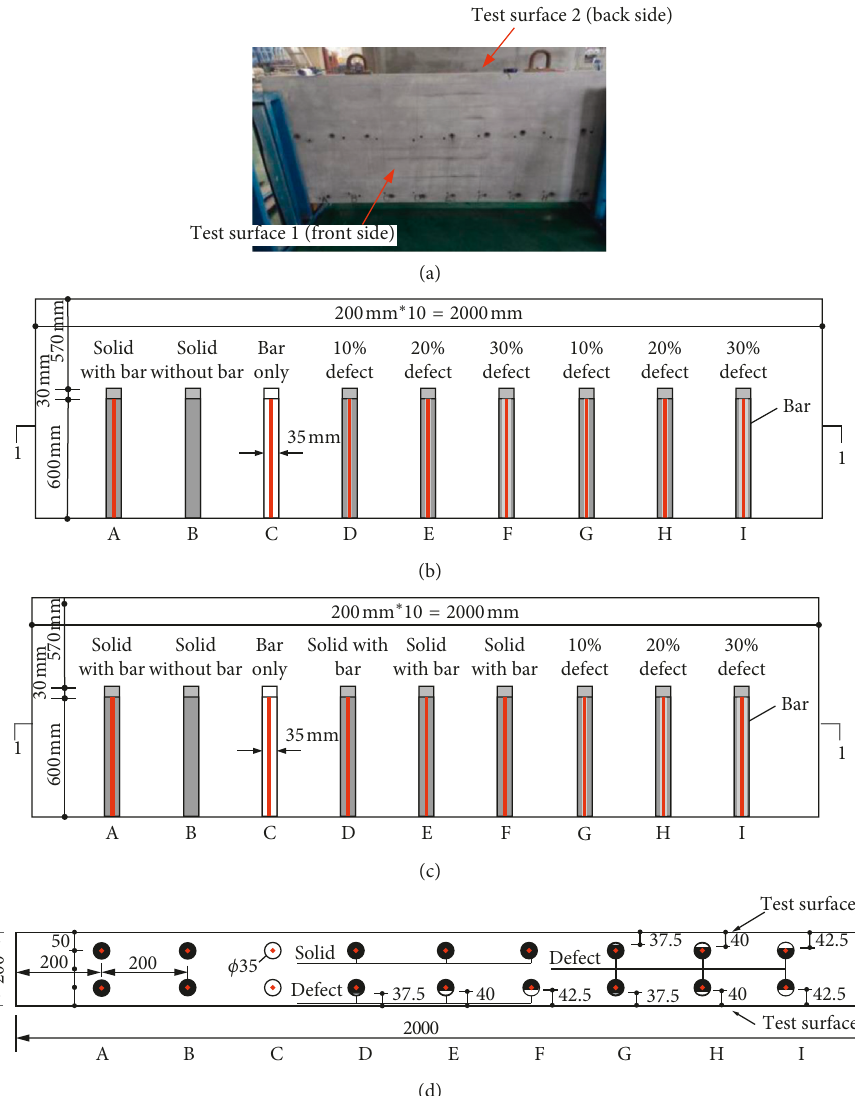
Figure 5: Details of the shear wall test specimen. (a) Photo of the test specimen. (b) Details of test surface 1. (c) Details of test surface 2. (d) Section 1-1.